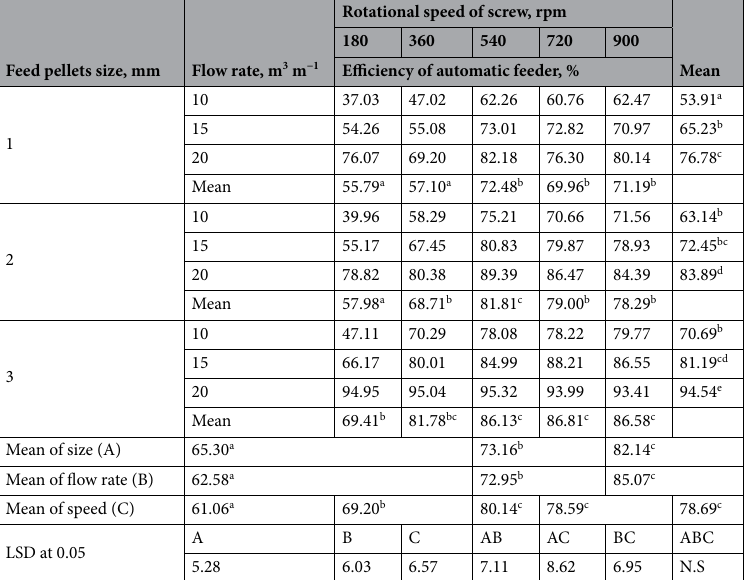
Feed pellets size, mm